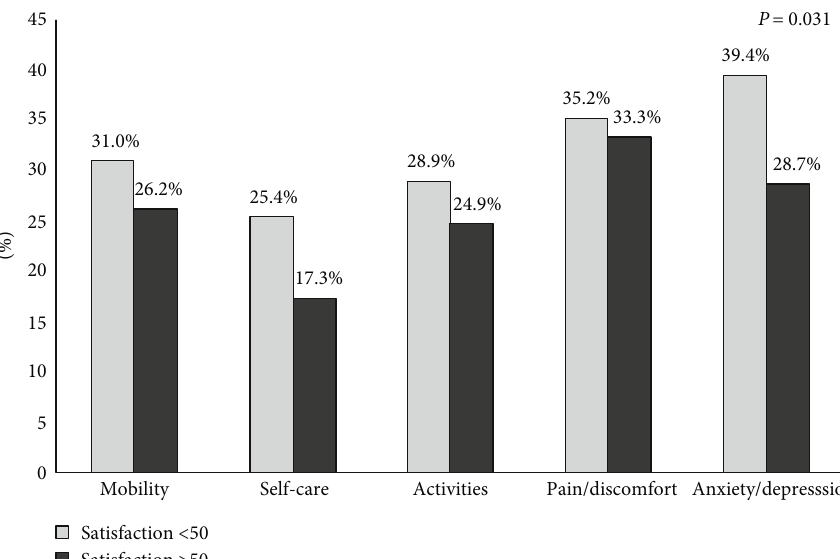
Figure 4: Classi fi cation of TSQM response domains for the EQ-5D.Notes: data are presented as the percentages of patients con fi rming some or considerable problems on each dimension of the EQ-5D. Grey columns, TSQM general satisfaction score < 50; black columns, TSQM general satisfaction score > 50. Table 3: EQ-VAS score correlation with treatment satisfaction. Satisfaction N Mean SD SE Overall satisfaction < less than 50 144 69.80 15.09 1.26 Overall satisfaction < more than 50 235 73.80 15.89 1.03 SD: Standard Deviation, SE: Standard